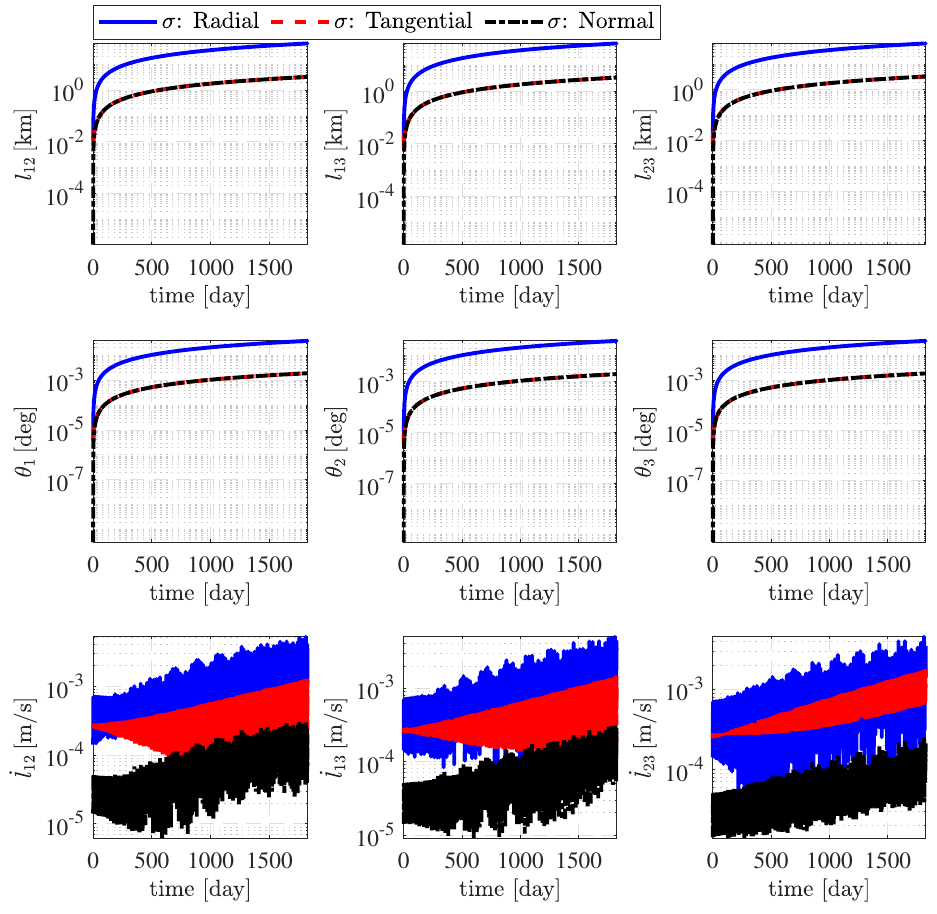
Figure 10. Effects of position insertion errors in different directions. Table 8. STDs of the three stability indexes considering velocity insertion errors in different